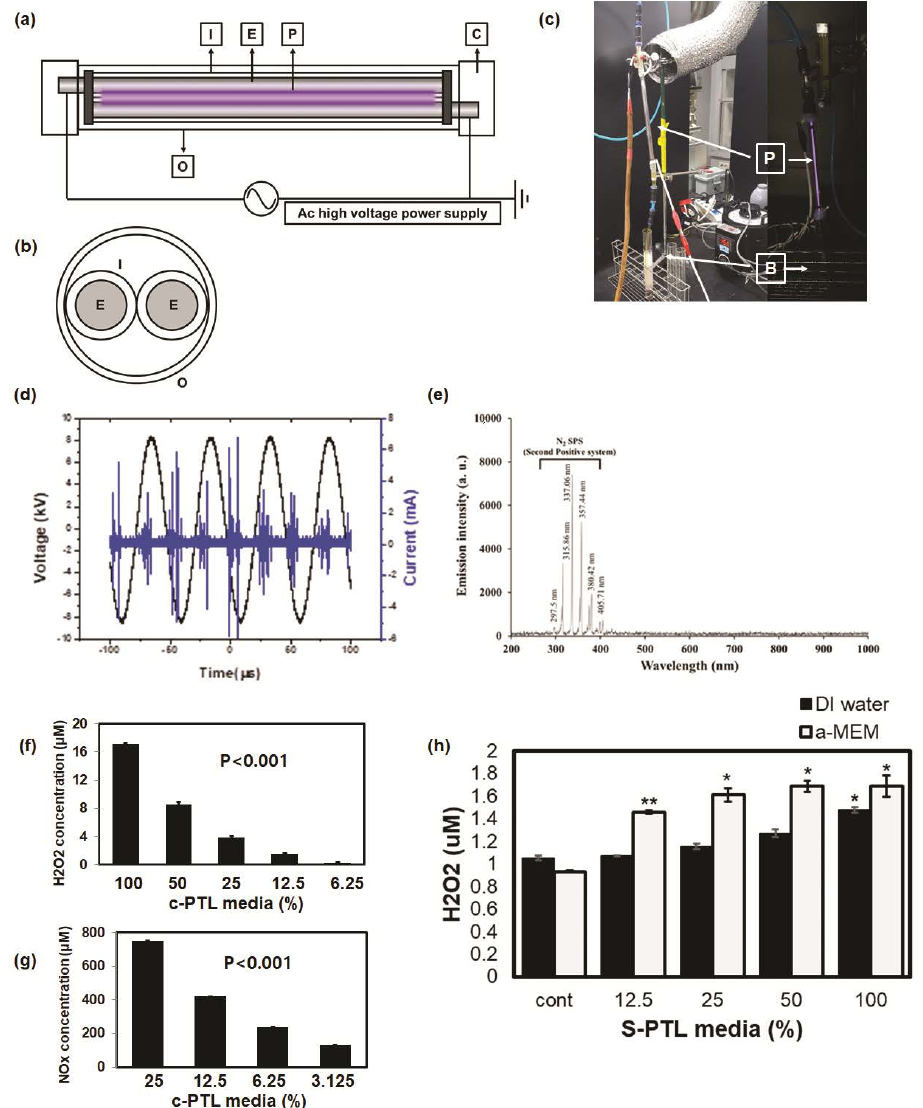
Figure 1. Characterization of plasma device for plasma-treated liquid (PTL). Front view ( a ) and cross-sectional view ( b ) of cylinder-type dielectric barrier discharge plasma device ( c ). I, inlet quartz tube; E, electrode; P, plasma discharged; C, connector with bubbler system; O, outlet quartz tube; B, bubbler system. Current and voltage waveforms ( d ) of the plasma discharge and the spectrum ( e ) of the plasma driven 8 kV p-p at 20 kHz with air gas flow rate is 1lpm. Hydrogen peroxide ( f ) and nitric oxide ( g ) were measured according to the dilution percentage from 50% to 3.125% (PTL/serum-free cell culture medium). For comparison, the hydrogen peroxide concen-trations were measured in the deionized water and cell culture medium ( h ). The level of signifi-cance was denoted as follows: * p < 0.05; ** p < 0.01; and *** p < 0.001.